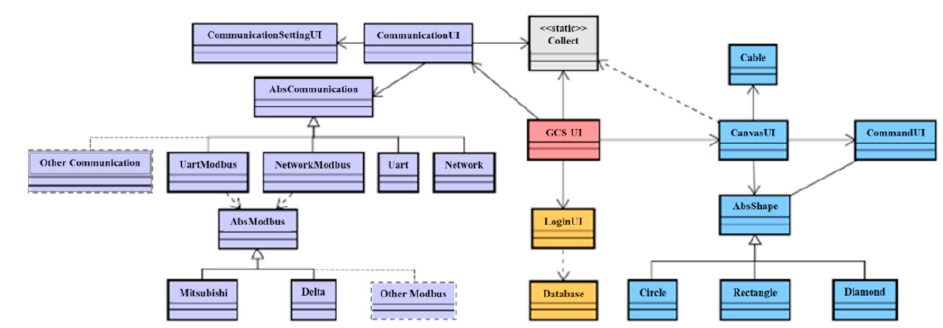
Figure 21. System architecture.